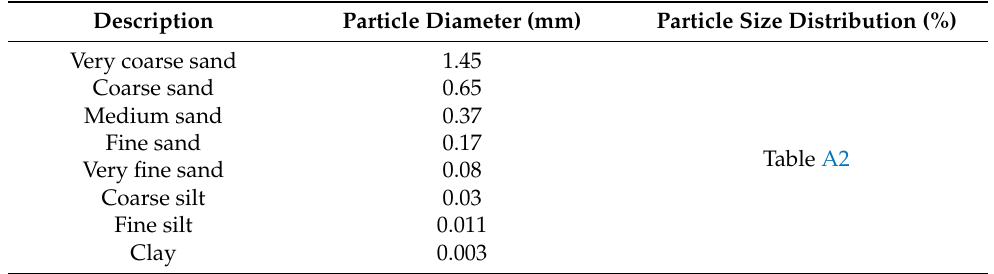
Table 1. Particle-size properties for the